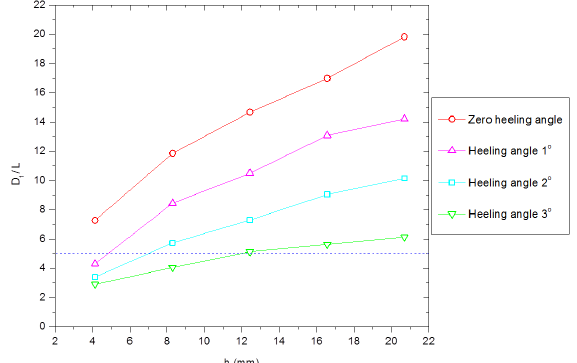
Figure 23: Simulated turning circles in 12 . 43 mm (0 . 3 m full-scale) level ice (power 120%, azimuth angle 35 ◦ ). (a) Zero heeling angle. (b) Heel- ing angle 3 ◦ . The turning circle is plotted with reference to ship length L .